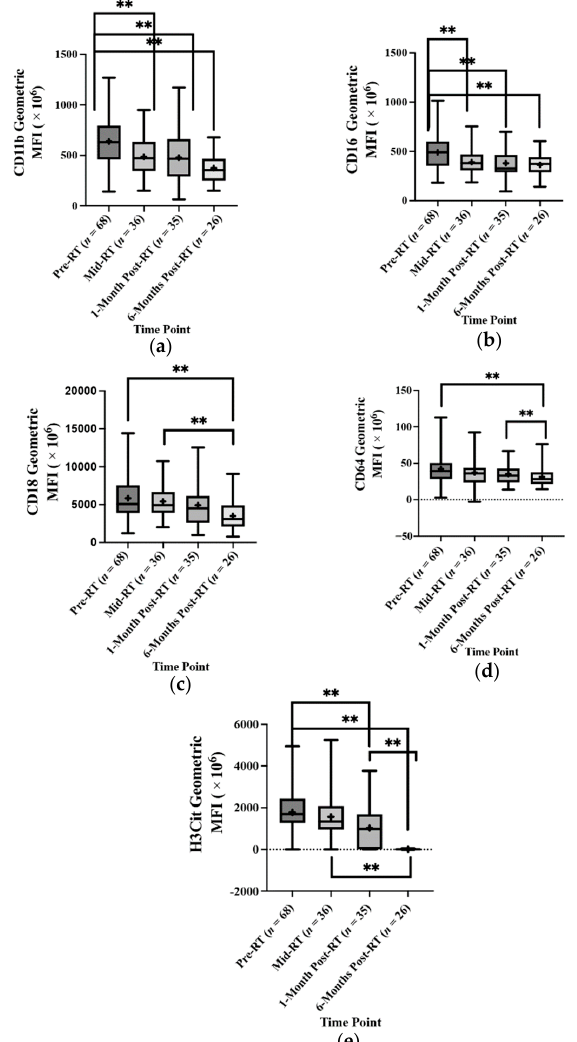
Figure 2. Radiotherapy significantly alters the oral neutrophil (oPMN) activation states. Oral neutrophils collected from HNT patients before, during and post-RT were labelled to analyse CD markers expression. The geometric mean fluorescence intensity (MFI) is shown for CD11b ( a ), CD16 ( b ), CD18 ( c ), CD64 ( d ) and H3Cit ( e ) across the four-time points. (+) The mean geometric MFI. (**) Statistically significant mean difference p < 0.005.